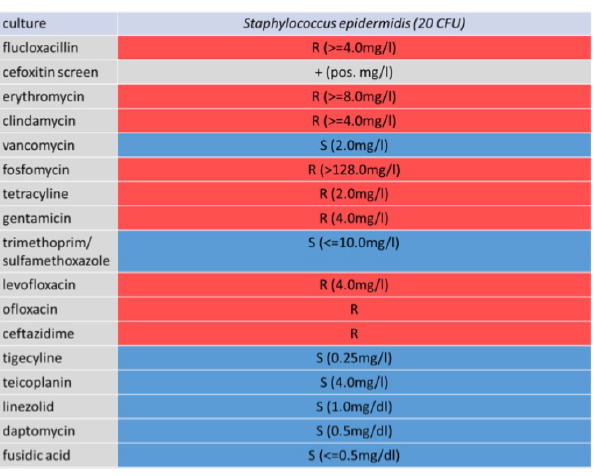
Figure 2. Antibiogram of the infection causative St. epidermidis